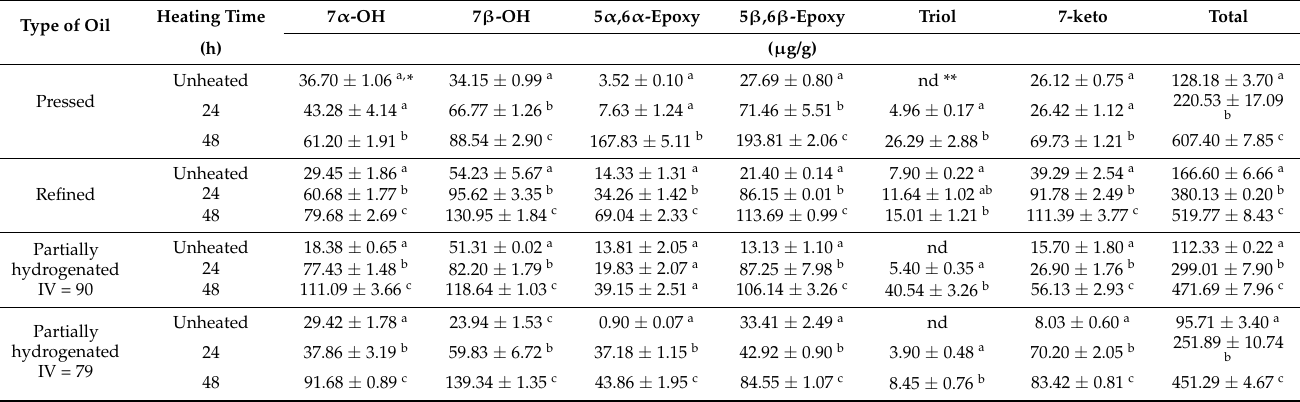
Values are means of three determinations ± SD. * Means in the same column followed by different letters indicate significant differences ( p < 0.05) between samples of each type of oil. ** nd—not detected. In unheated oils, the main group of β -sitosterol oxidation products were 7 α - and 7 β -hydroxy sterol, which together accounted for 50% or more of the total content of β - sitosterol derivatives. In pressed oil and the second partially hydrogenated oil (IV = 79), 7 α - and 7 β -derivatives were at similar level and were 36.7, 34.15, 29.42, and 23.94 µ g/g of oil, respectively. In refined oil and the first partially hydrogenated oil (IV = 90), 7 β - hydroxy derivatives were at a higher level, compared to 7 α -hydroxy, and were 64.8% and 73.6% of these compounds, respectively. At a high level, the presence of 7-keto (39.29 µ g/g) in refined oil and derivatives 5 β ,6 β -epoxy β -sitosterol (33.41 µ g/g) in the second of hydrogenated oils (IV = 79) was also observed. The heating process leads most often to changes of the profile of the oxidation products of β -sitosterol in analyzed samples. During the heating of pressed oil, a sharp increase of 5 α ,6 α -epoxy and 5 β ,6 β - epoxy derivatives of β -sitosterol was observed. After 48 h of heating, the contents of those compounds amounted to 167.83 and 193.81 µ g/g of oil. A very high increase of 5 β ,6 β -epoxy β -sitosterol was also observed in the refined and the first of the partially hydrogenated oil (IV = 90). The content of 5 β ,6 β -epoxy at the end of the heating process was 113.69 and 106.14 µ g/g of oil, respectively. After heating in refined oil, the high content of 7 β -hydroxy (130.95 µ g/g) and 7-keto derivatives (11.39 µ g/g) was also observed. In both partially hydrogenated oils, heating also led to an increase in the content of 7-hydroxy derivatives of β -sitosterol, which ultimately accounted for about 50% of the total oxidized